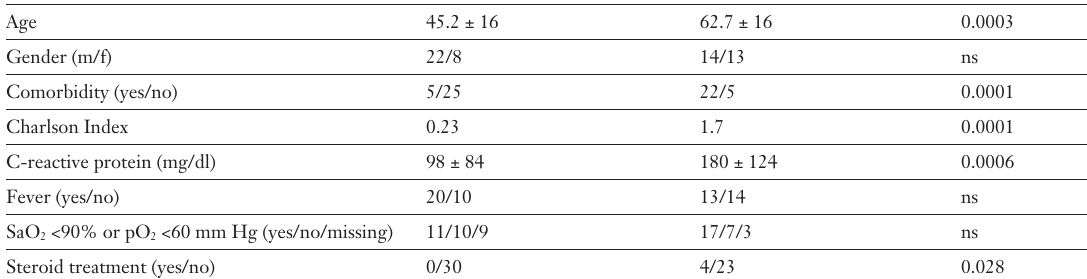
Univariate charac- teristics of low-risk patients with CAP